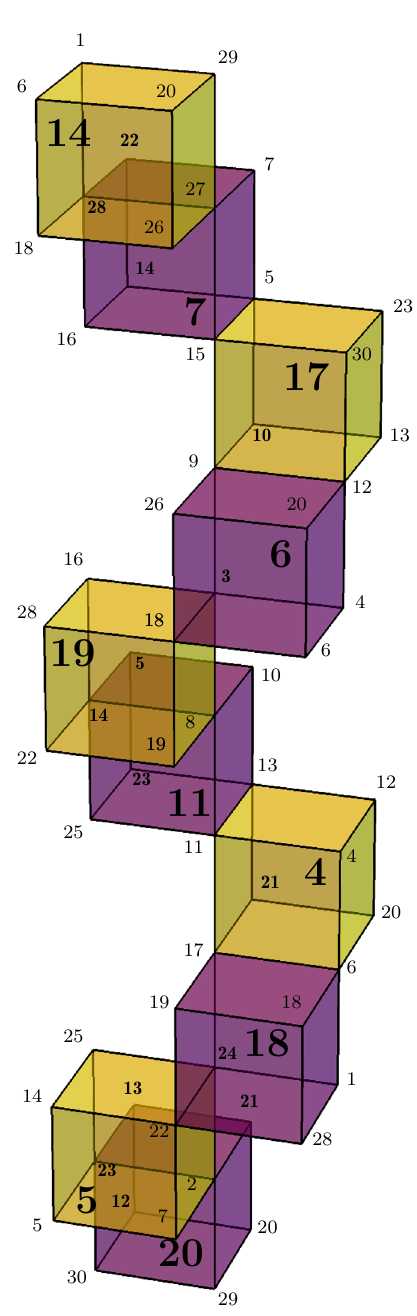
Figure 14 . A Z = 10 Z orbit of the dual facets. The generator A 2 B runs through these dual facets, in the order given, from top to bottom. The facets shown in yellow and purple are distinct A orbits. The dual facets are numbered in large boldface, according to table 12 and the dual vertices are numbered in eight point font. The edge f f 20 ; f 29 g of v 20 is identi(cid:12)ed with the corresponding edge of v 14 .